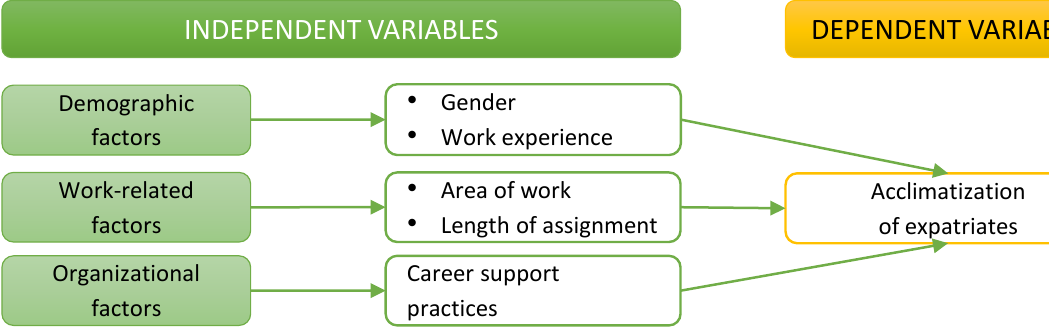
Figure 1. Dependent and independent